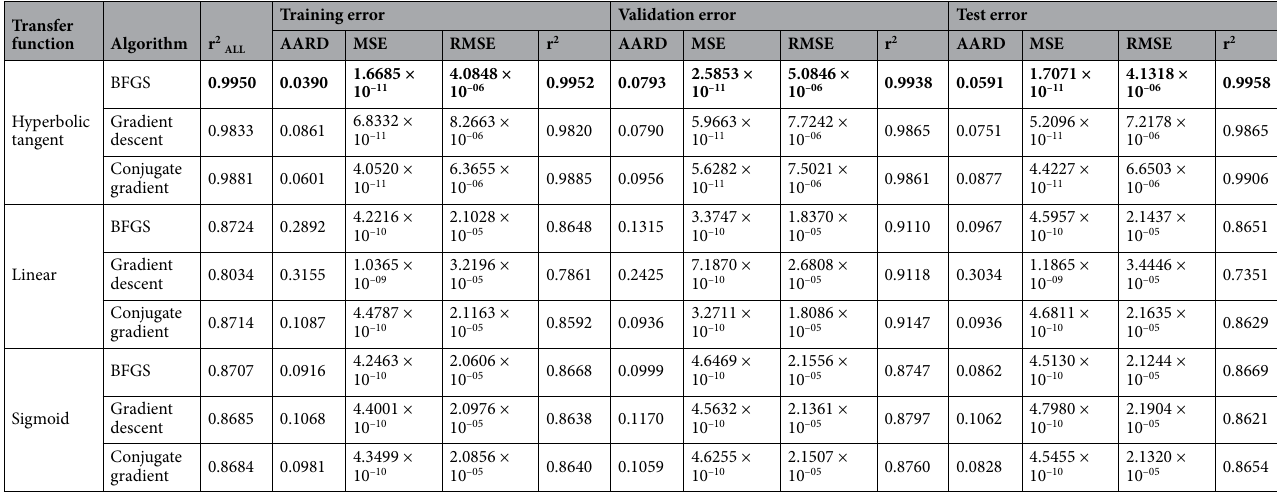
Table 7. Comparison of errors of various training algorithms for estimation of fouling resistance. Significant values are given in